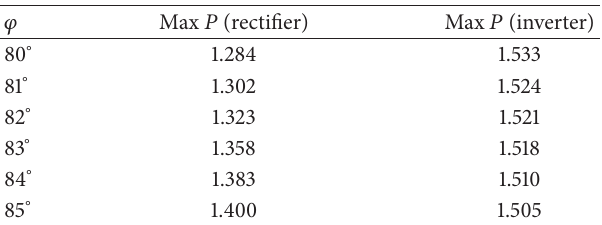
Table 5: Calculation result of power transfer limitations with different 𝜑